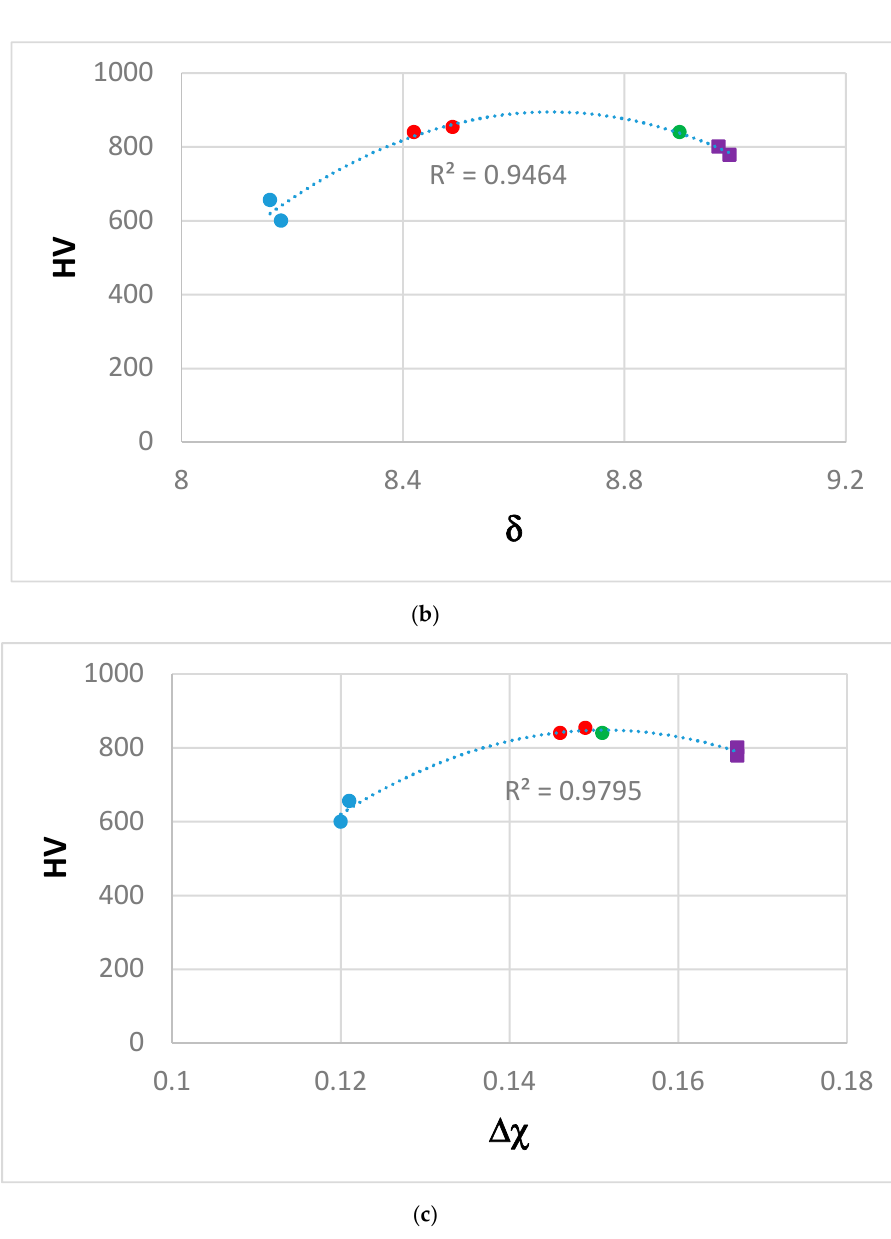
Figure 8. Vickers hardness (HV) versus VEC ( a ) or δ ( b ) or ∆ χ ( c ) of the alloys KZ5 = Nb-24Ti-18Si-5Al-5Cr [12] (blue), JN1 = Nb-24Ti-18Si-5Al-5Cr-5Hf [46] (green), ZF6 (red) and ZF9 (purple).